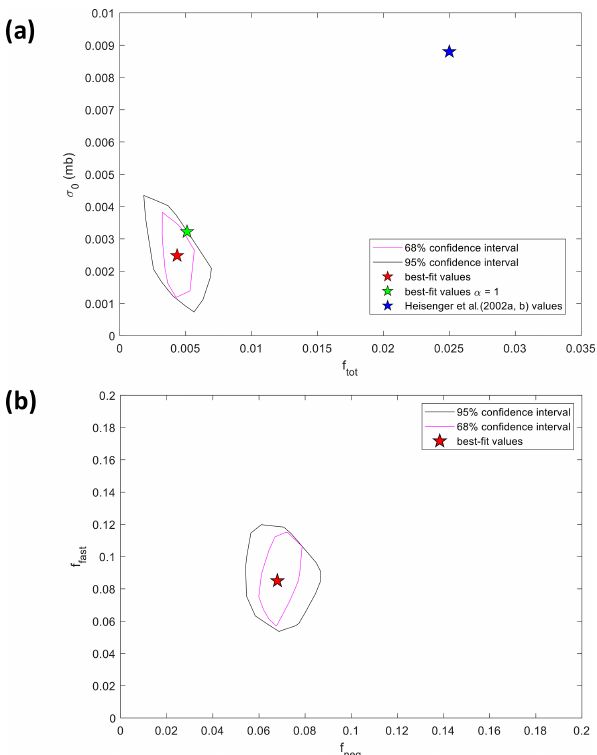
Figure 7. (a) The 68% and 95% CI contours of accepted σ 0 and f tot values for total 14 C. (b) The 68% and 95% CI contours of accepted f neg and f fast values for 14 CO (see Sect. 5.4.3). For com- parison, the σ 0 and f tot values from Heisinger et al. (2002a, b) are shown as a blue star. The best-fit values for σ 0 , f tot , f neg , and f fast are shown as a red star in both figures. The best-fit values for σ 0 and f tot are when α (energy scaling in Eq.